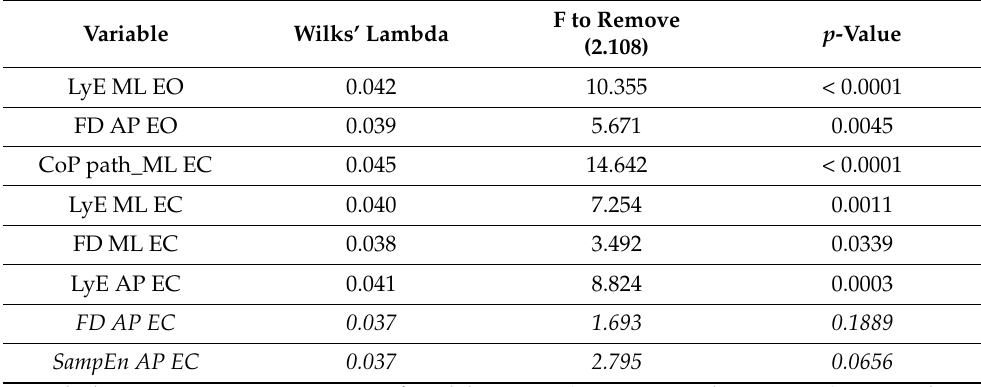
Table 3. Results of the discriminant analysis—model with 8 variables. Non-significant variables are marked with italic.